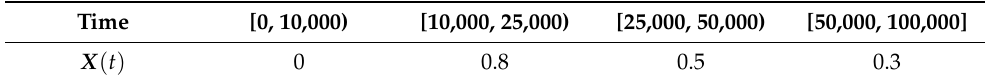
Table 1. Step covariate function.